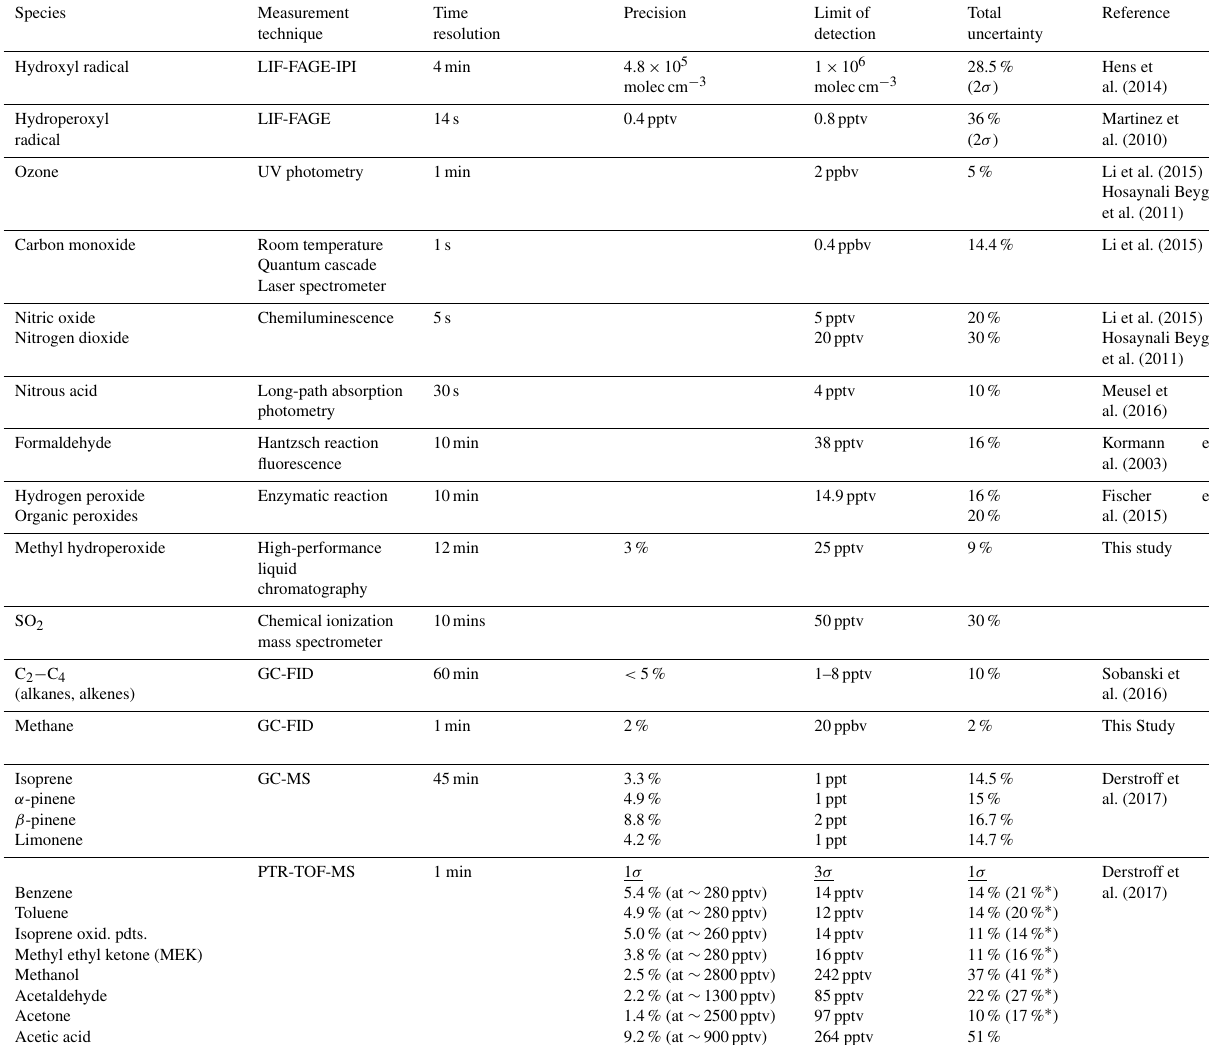
Table 1. Details of experiments conducted during CYPHEX (relevant to this study). PTR-TOF-MS: proton-transfer-reaction time-of-flight mass spectrometry. GC-FID: gas chromatography–flame ionization